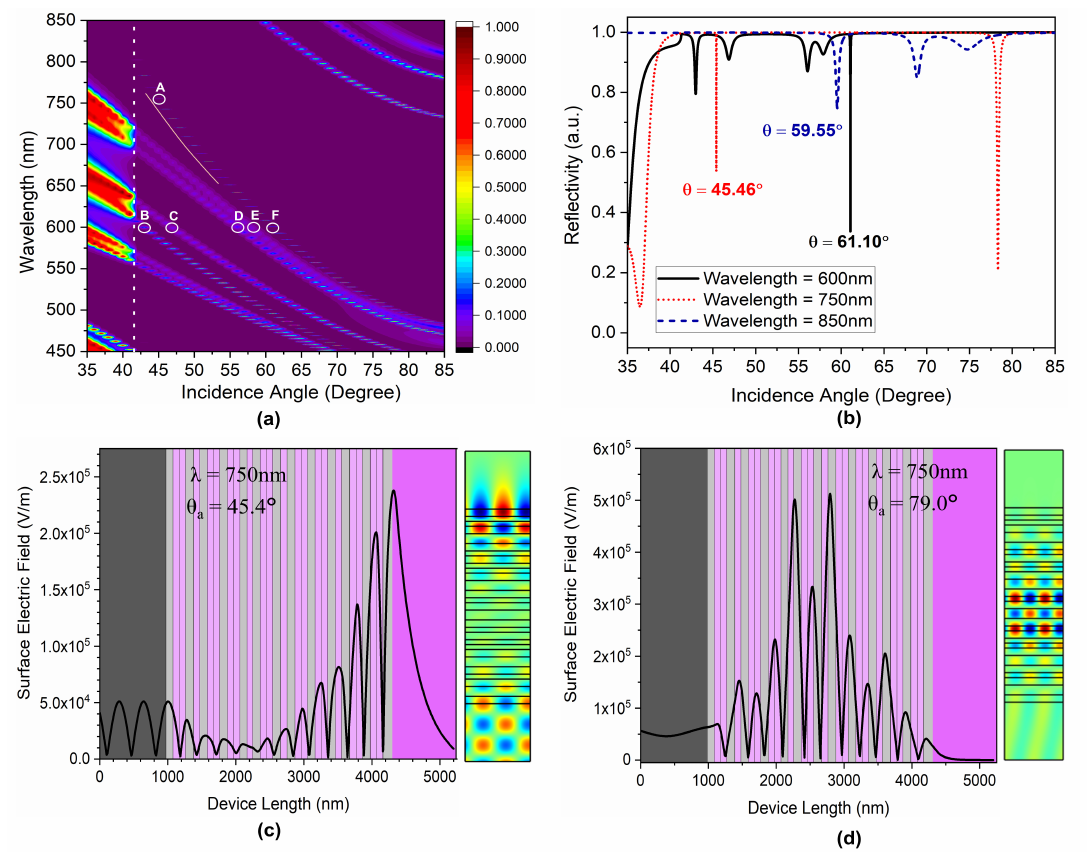
Figure 4. Transmission characteristics of the proposed structure at an oblique incidence angle for n = 7 QPhC: ( a ) angular dispersion characteristic, ( b ) angular reflectance characteristic, ( c ) normalized surface electric field confinement along with the length of the proposed structure for 750 nm operating wavelength at 45.4° incidence angle, and ( d ) normalized surface electric field confinement structure for 750 nm operating wavelength at 79.0° incidence